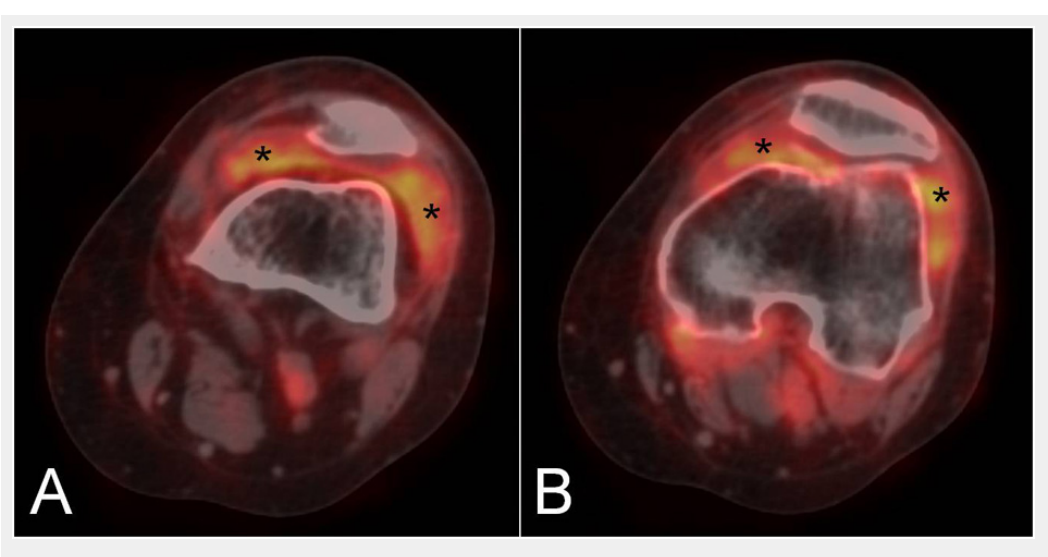
Figure 2 Two sequential PET/CT fused images of the knee in a patient with rheumatoid arthritis showing diffuse F18-FDG uptake in the medial and lateral paracondylar recesses